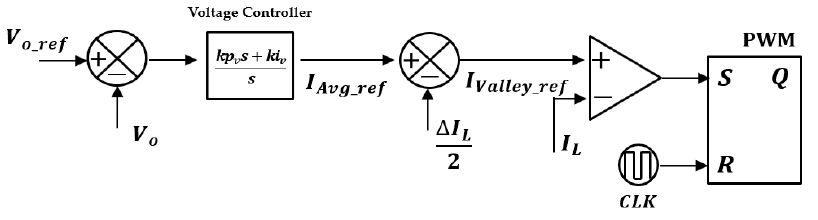
Figure 11. Block diagram of Valley current mode control.